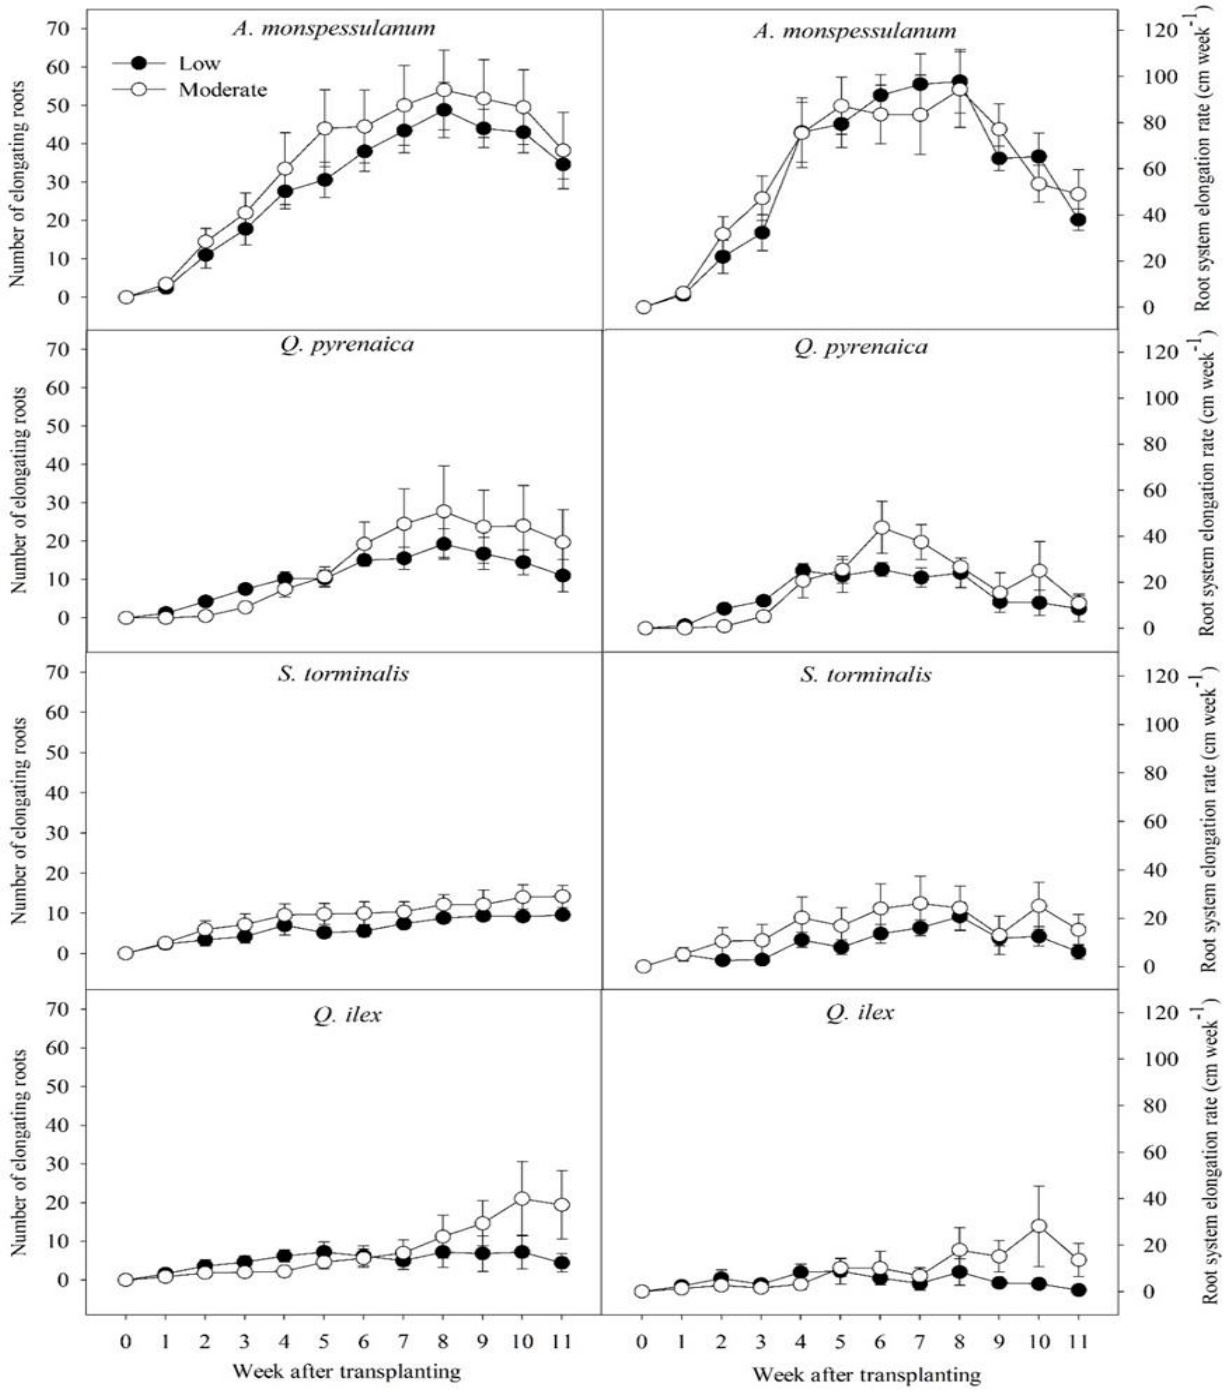
Figure 3. Number of elongating roots (left) and root system elongation rate (right) in seedlings of four broadleaf Mediter- ranean species grown into rhizotrons under low (17%) and moderate (33%) light levels. Data are means ± one SE.